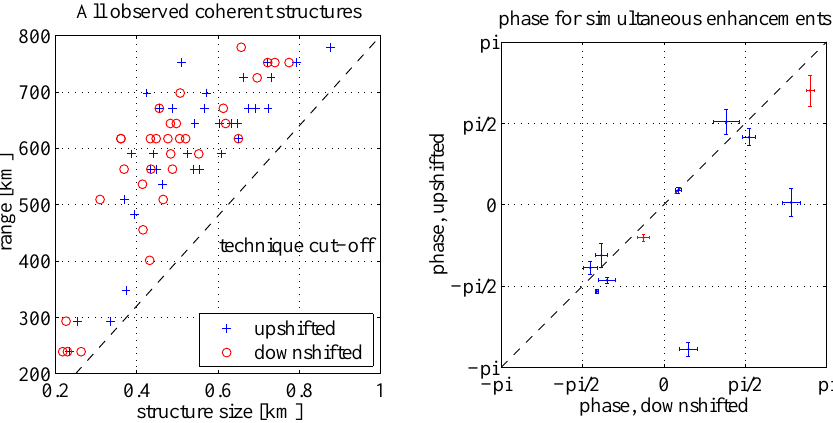
Fig. 12. (a) (left panel) All observed coherent structures, plotted versus range and maximum structure size. (b) (right panel) Phase in the coherent upshifted enhancement versus phase in the coherent downshifted